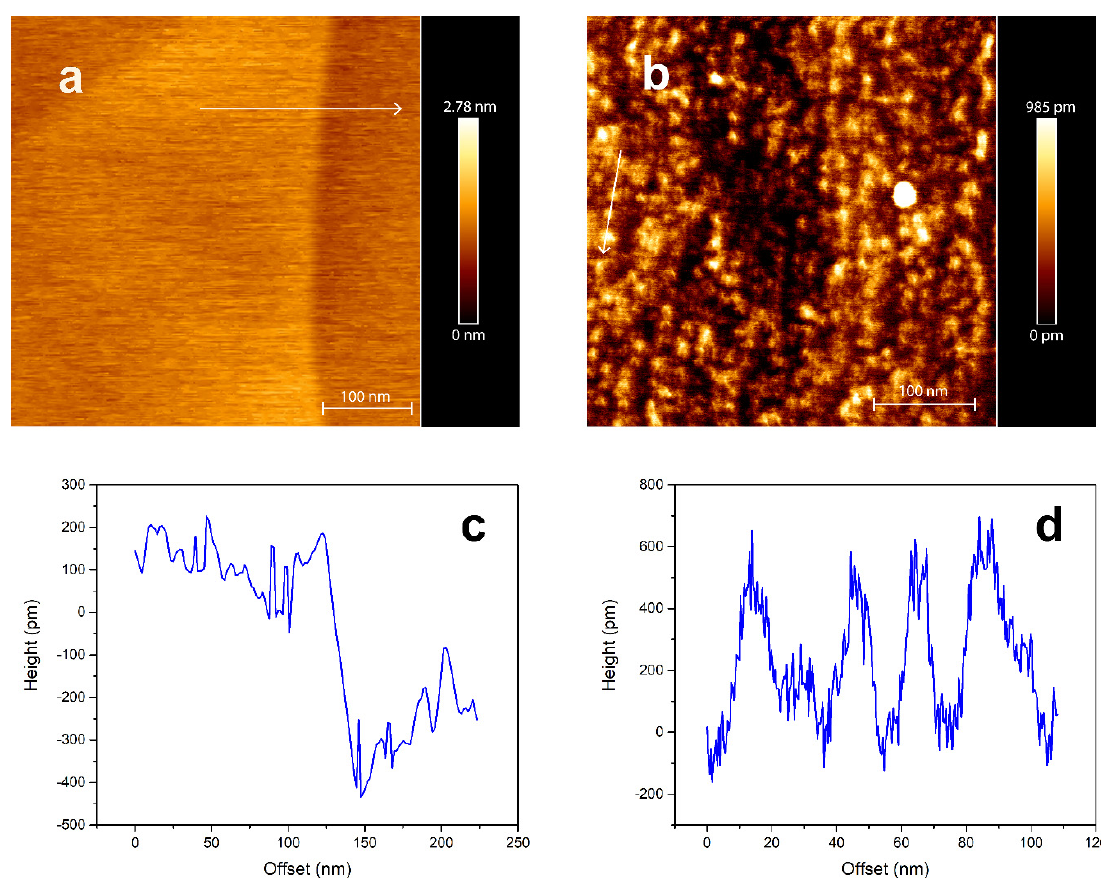
Figure 4. AFM images of ( a ) unirradiated HOPG surface, ( b ) surface irradiated with 23 MeV I at grazing incidence with ( c ) height profile across surface step and ( d ) height profile of the ion track indicated in ( b ).